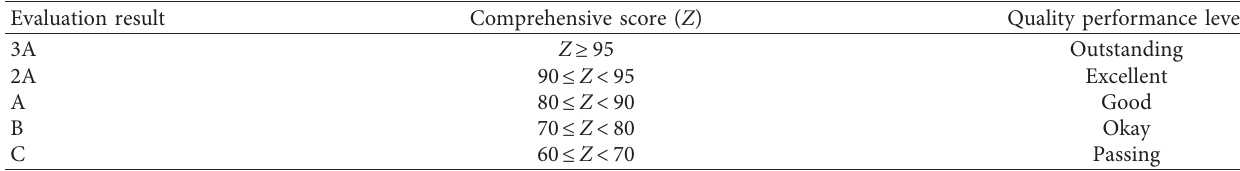
Table 6: Evaluation results, comprehensive score, and performance level of CQMS.